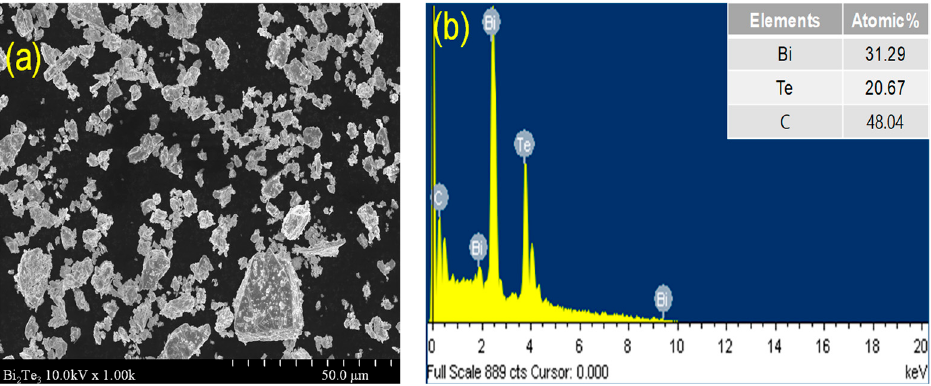
Figure 1. Measured ( a ) SEM image and ( b ) EDS spectrum of the Bi 2 Te 3 powder used in this work. To form Bi 2 Te 3 film for the Bi 2 Te 3 -based SA, the Bi 2 Te 3 powder is mixed with 2 ml of distilled water without any post-processing, such as ultrasonication and stirring with mechanical facility.